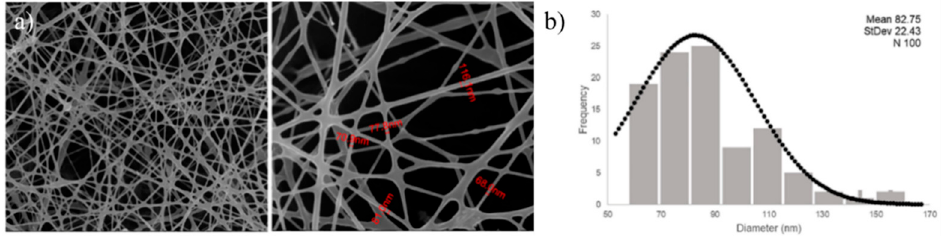
Figure 10. FESEM images of the chitosan, poly(ethylene) oxide, cellulose nanocrystals nanofibers incorporated with acacia extract ( a ). Diameter distribution histogram ( b ). Used with permission from [116].